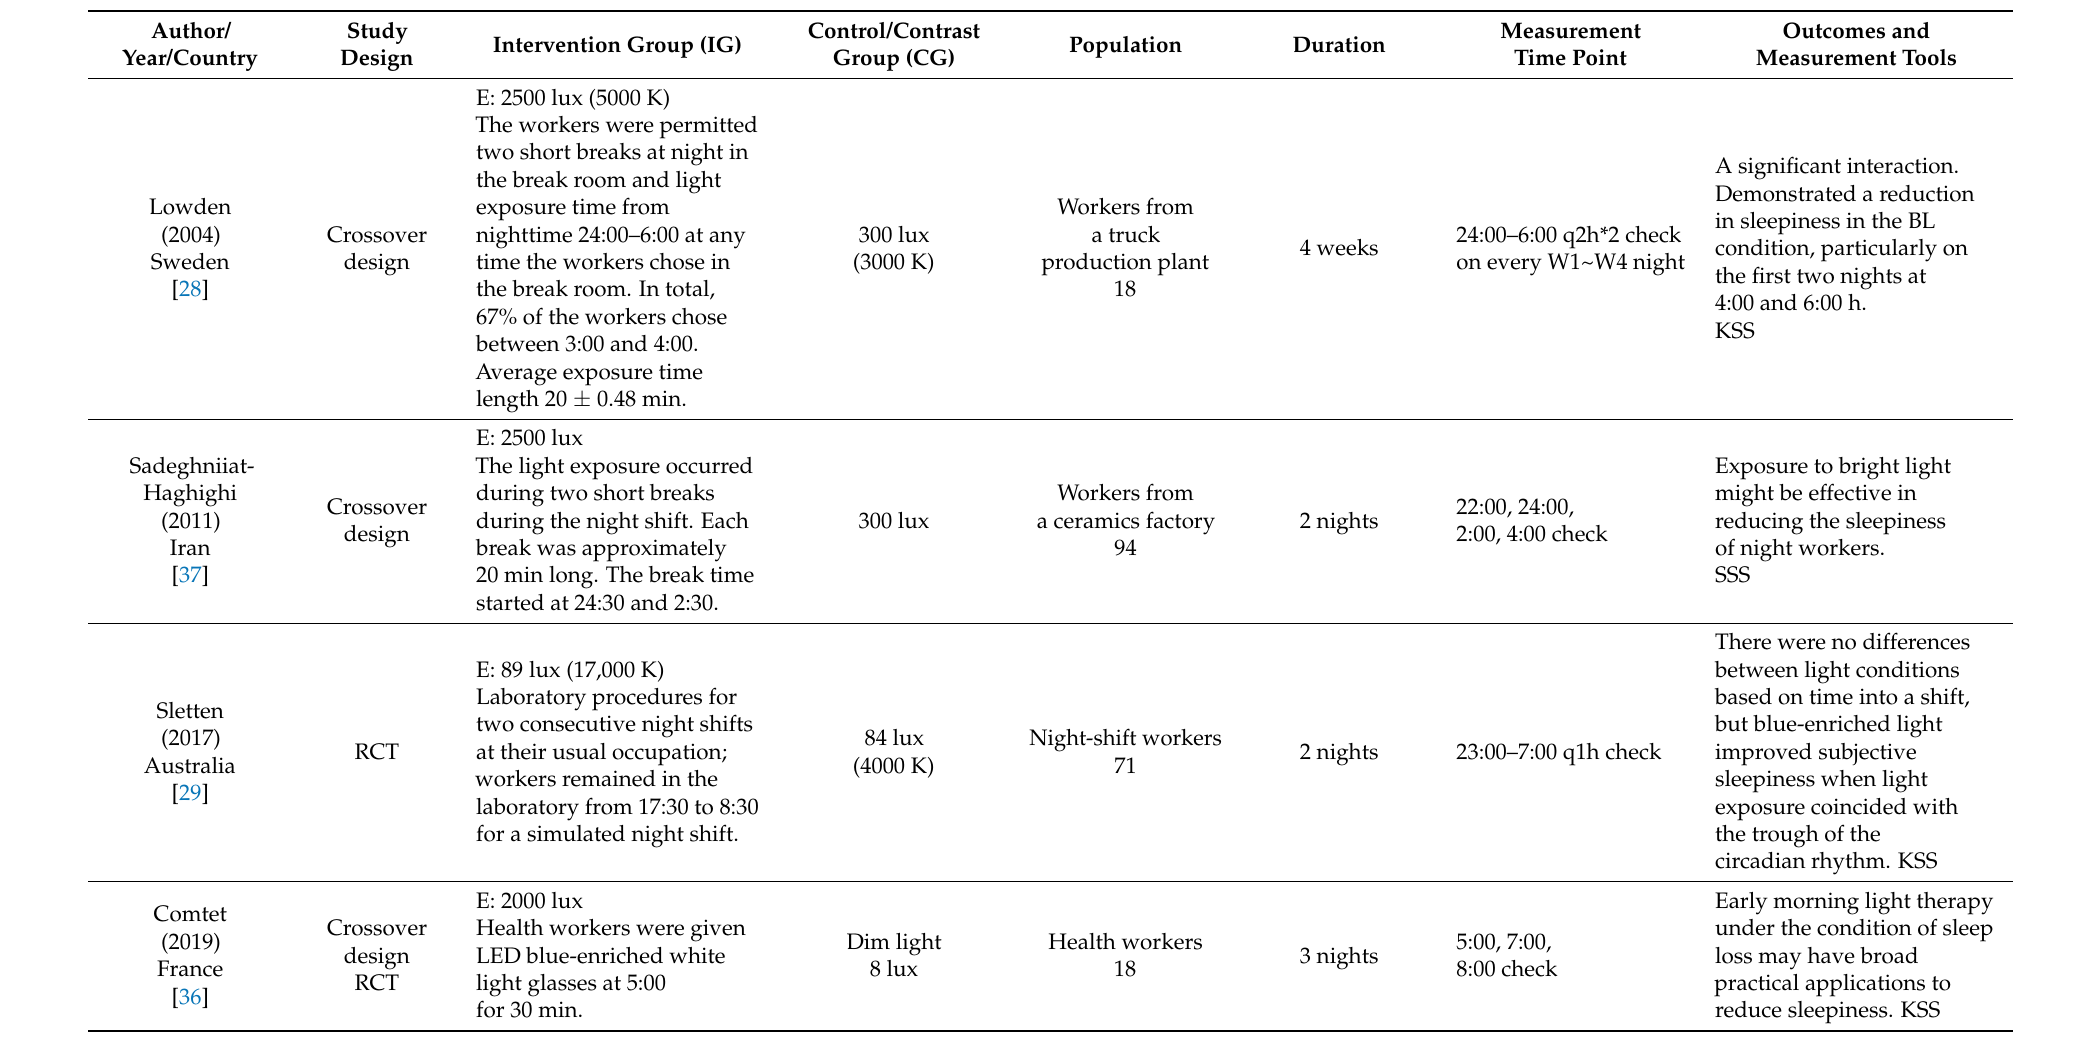
Table 1. Characteristics and outcomes of included